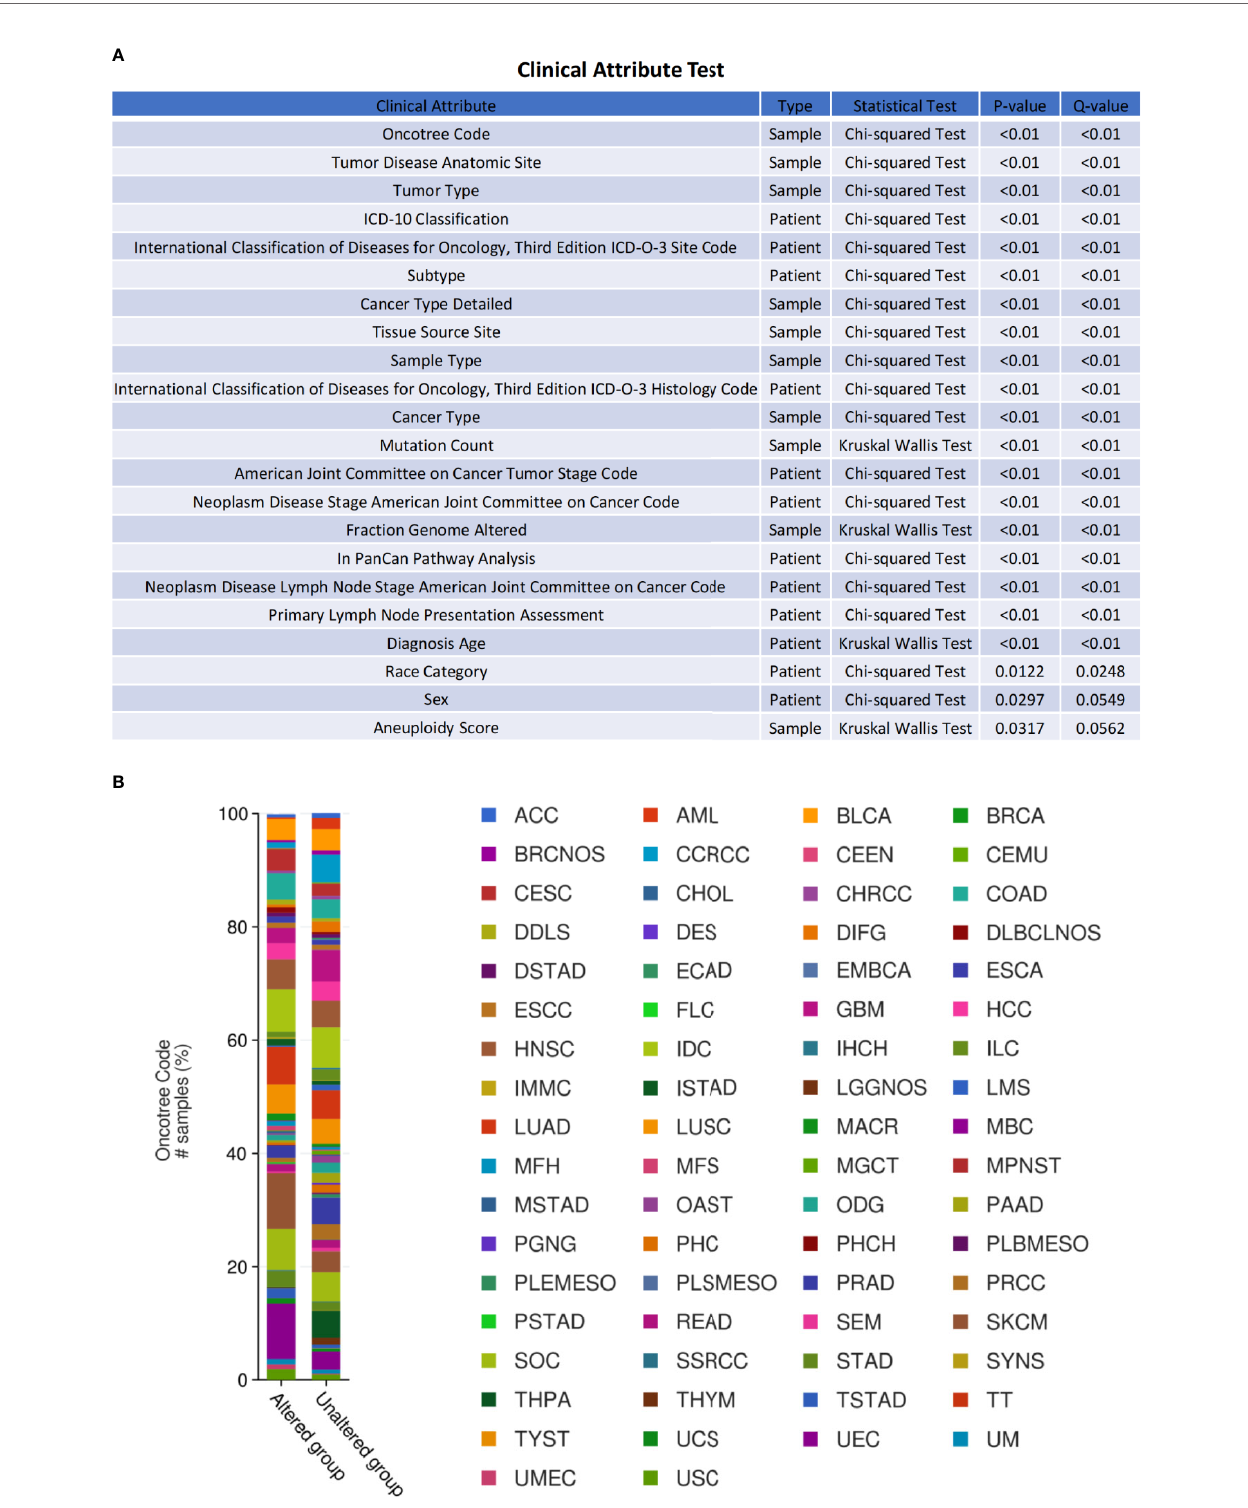
FIGURE 7 | Clinical relevance of ESR1 , ESR2 , and PGR alterations across multiple cancer types. (A) OncoTree code of ESR1 , ESR2 , and PGR in different cancer types. (B) Clinical attribute test of ESR1 , ESR2 , and PGR in different cancer types.